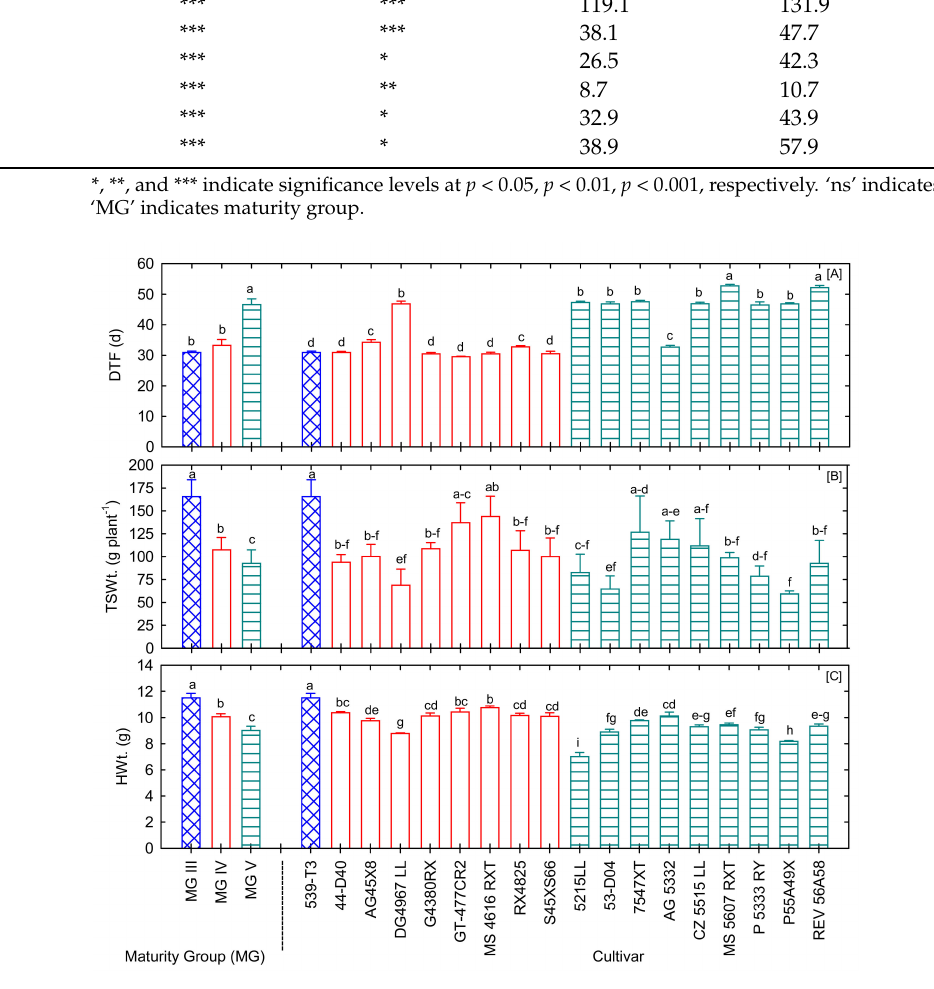
Figure 2. Variations in yield components of 18 soybean cultivars under well-watered and fertilized conditions: ( A ) days to 50% flowering (DTF), ( B ) total seed weight (TSWt., g plant − 1 ), and ( C ) 100-seed weight (HWt., g). Bars denote mean ± SE ( n = 5). Bars with the same letter(s) indicate no significant differences among maturity groups (MG) or cultivars at p < 0.05